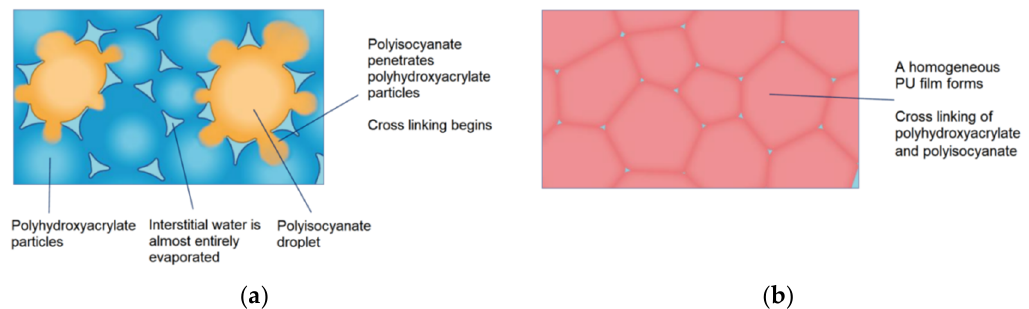
Figure 6. The process of film formation and curing of a two-component waterborne polyurethane coating. ( a ) Process of diffusion between polyhydroxyacrylate particles and polyisocyanate droplets; ( b ) Chemical crosslinking in fully diffused and fused resin.